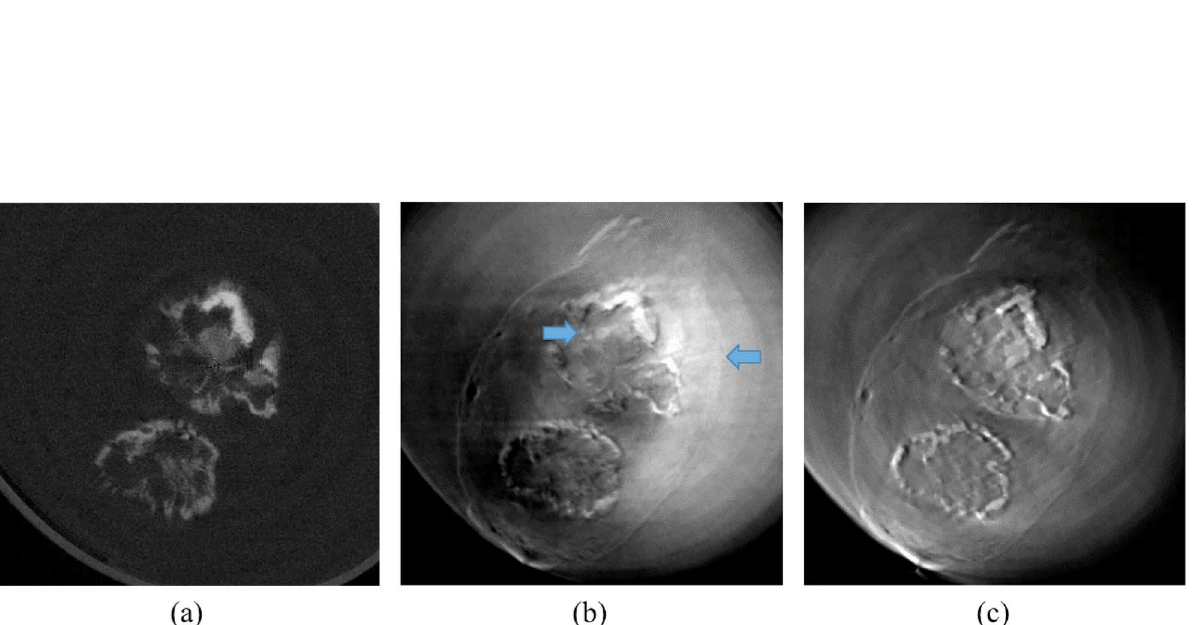
PLOS ONE | DOI:10.1371/journal.pone.0135654 August 21, 2015 13 /